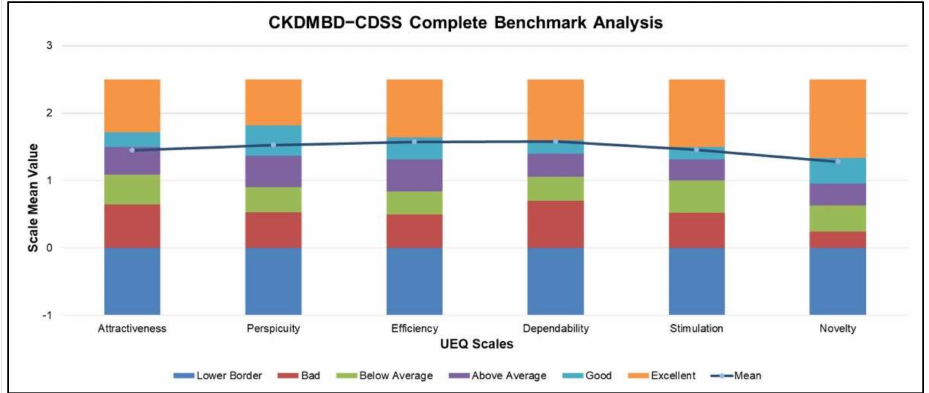
Figure 16. CKD–MBD CDSS Benchmark